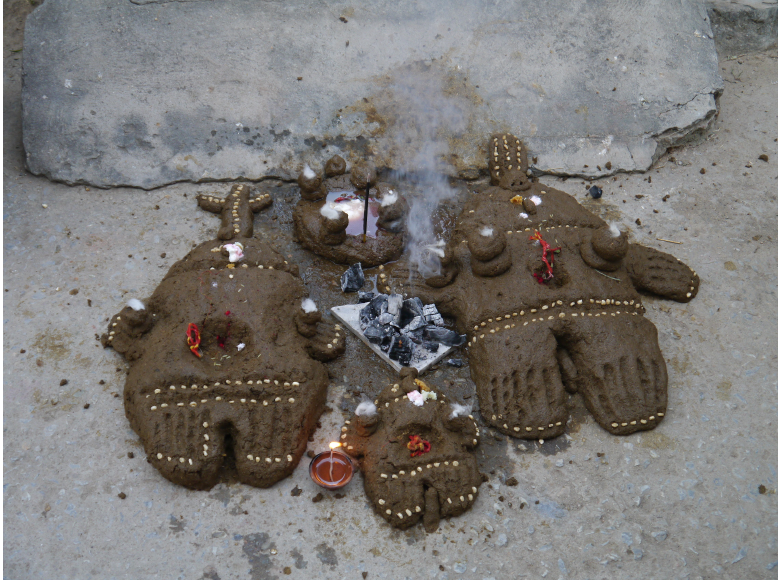
Figure 6. Cow dung sculpture representing the fertile family and the fertile local landscape, Havala, October 2017—photo by